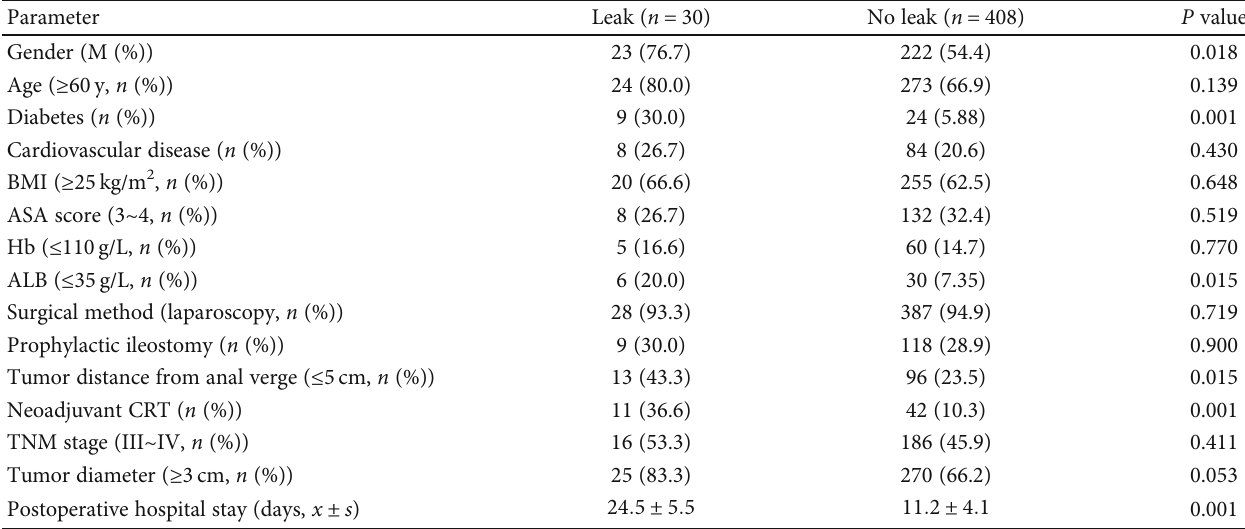
Table 1: Demographic and clinical